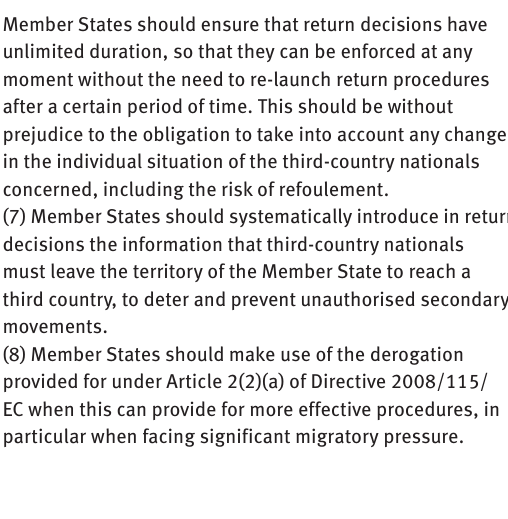
Table 2: Text 1 (original text in English and machine translation into Spanish)